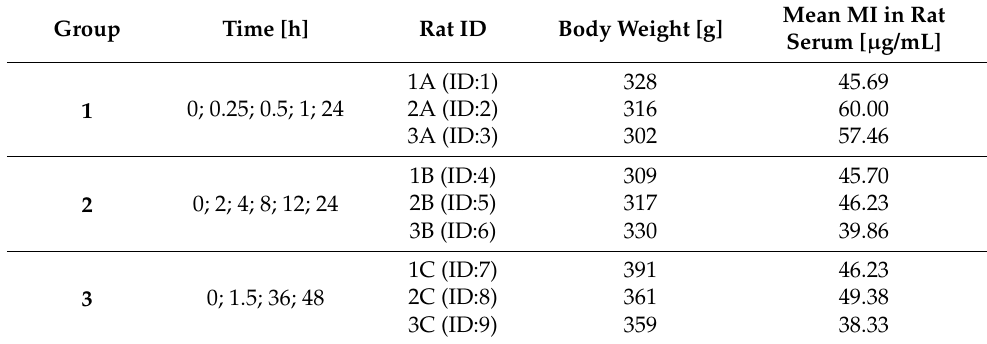
Figure 3. Myo-inositol concentrations in Wistar rat serum: ( A ) in groups 1A, 2A and 3A at time-points 0 h, 15 ′ , 30 ′ , 60 ′ , 24 h; ( B ) in groups 1B, 2B, 3B at time-points 0 h, 2 h, 4 h, 8 h, 12 h, 24 h; ( C ) in groups 1C, 2C, 3C at time-points 0 h, 1.5 h, 36 h, 48 h; ( D ) summary of concentrations in all time-points; ( E ) mean concentrations in all time-points. Table 2. Detailed information about animals and study design. Blood samples in the volume of 200–300 µL were collected from the tail and centrifuged; the serum was then collected and stored at − 80 °C until further analysis.